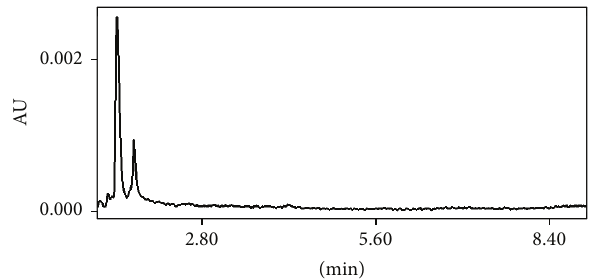
Figure 1: Representative chromatogram of blank plasma mouse after the MEPS procedure.